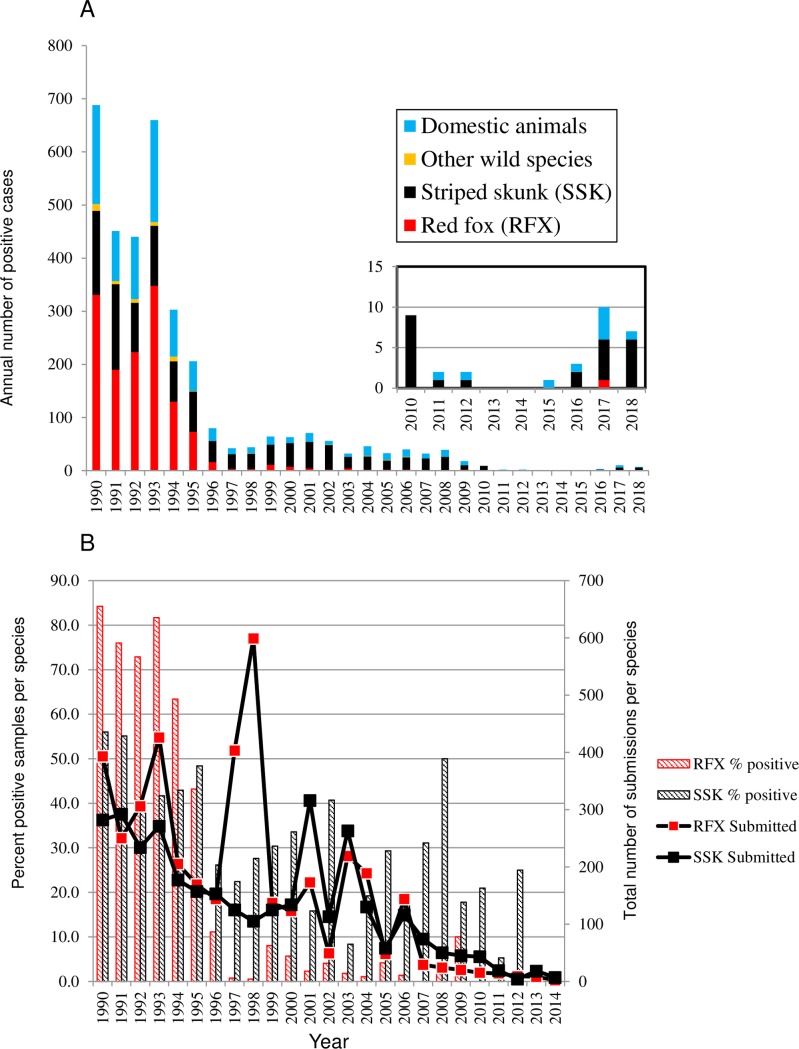
Panel A. Summary of rabies cases due to the AFX variant in 11 counties of southwestern Ontario 1990 to May 2018. The inset shows the recent case data from 2010 onwards at a different scale. Panel B. Total submissions and the percentage of all submissions testing rabies positive by year for the red fox (RFX) and skunk (SSK) hosts within the study zone. Data beyond 2014 are not shown as submissions in recent years were extremely low and sporadic.